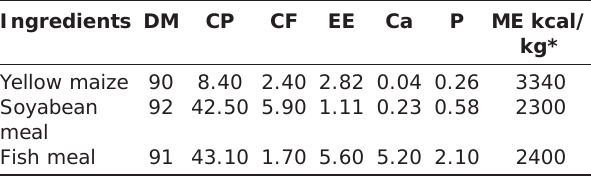
Table-1: Percentage chemical composition and metabolizable energy of feed used in experiment (on DM basis).